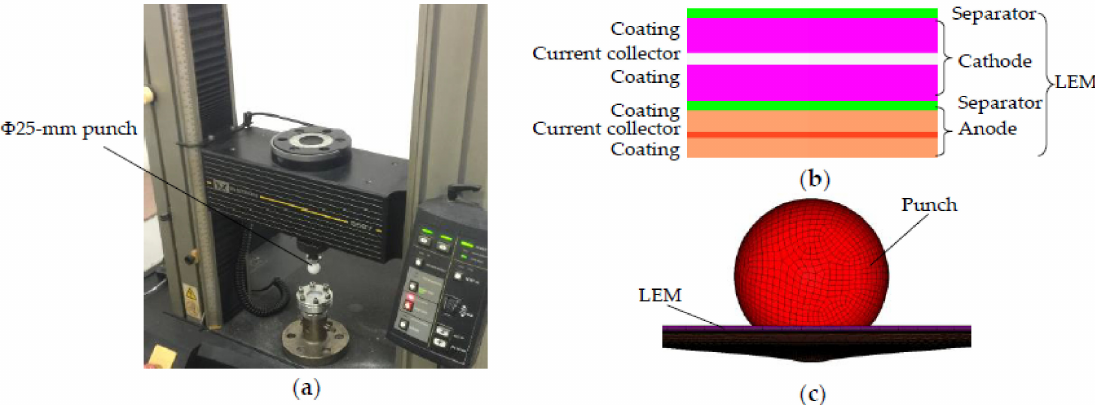
Figure 10. Test and simulation of an layer element model (LEM) under spherical punch: ( a ) Experimental setup; ( b ) A layer element structure model; ( c ) Finite element model of a layer